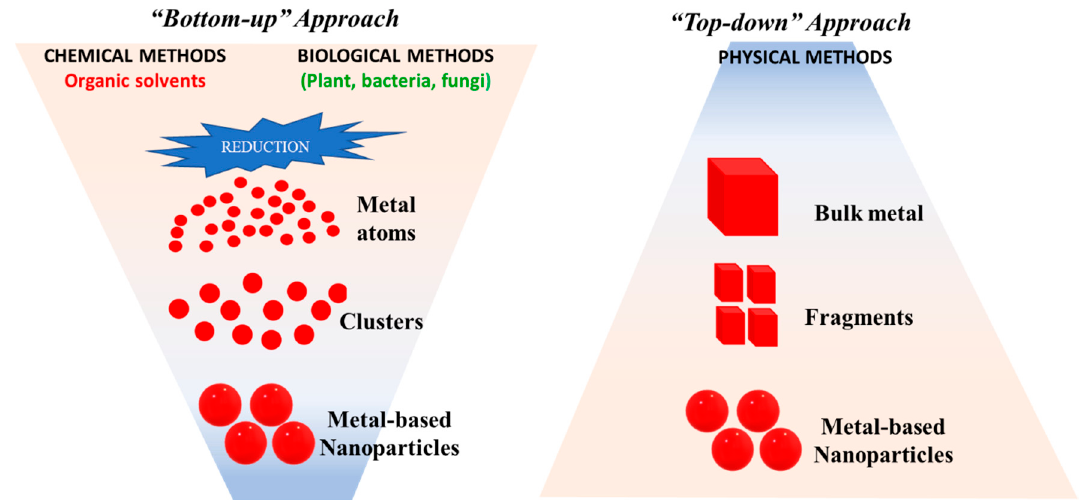
Figure 2. Different methods used for the synthesis of metal-based nanoparticles. Figure 2. Di ff erent methods used for the synthesis of metal-based